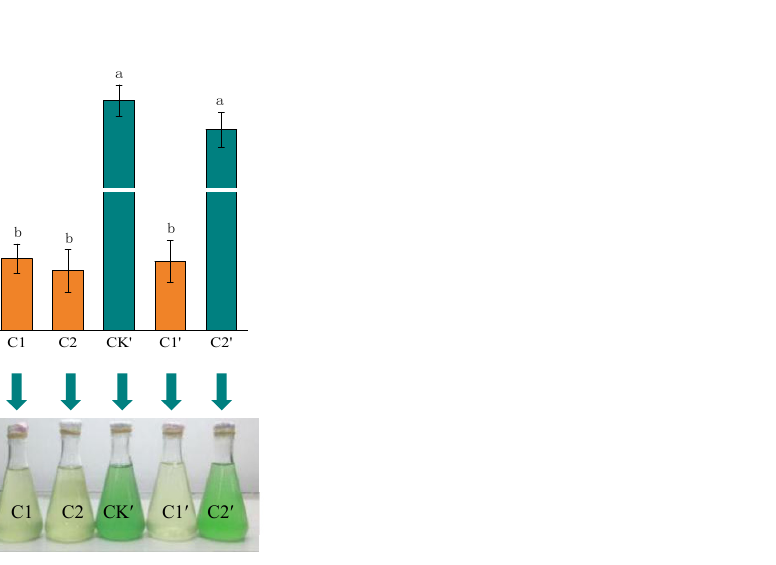
Figure 6. Treatment effects of the RTS-4 bacterial strain on Hg-containing sewage. ( A ) Chlorella vulgaris (CV) without any treatment (CK); addition of CV after 24 h (CK’); addition of CV treated with 10 mg/L Hg(II) (C1); addition of CV after 24 h treatment with 10 mg/L Hg(II) (C1 ′ ); addition of CV treated with 10 mg/L Hg(II) and RTS-4 Hg-tolerant bacteria (C2); and addition of CV after 24 h treatment with 10 mg/L Hg(II) and RTS-4 Hg-tolerant bacteria (C2 ′ ). The CV and Hg-tolerant bacteria added to each experimental group were 20% and 6% at concentrations of 3 × 10 7 cells/mL and 10 9 CFU/mL, respectively. ( B ) CV growth effects on Hg-containing sewage in different treatment groups. Bars (mean values ± SD) with different letters show significant differences at the 0.05 level, according to the test or multiple LSD comparisons from three independent experiments.